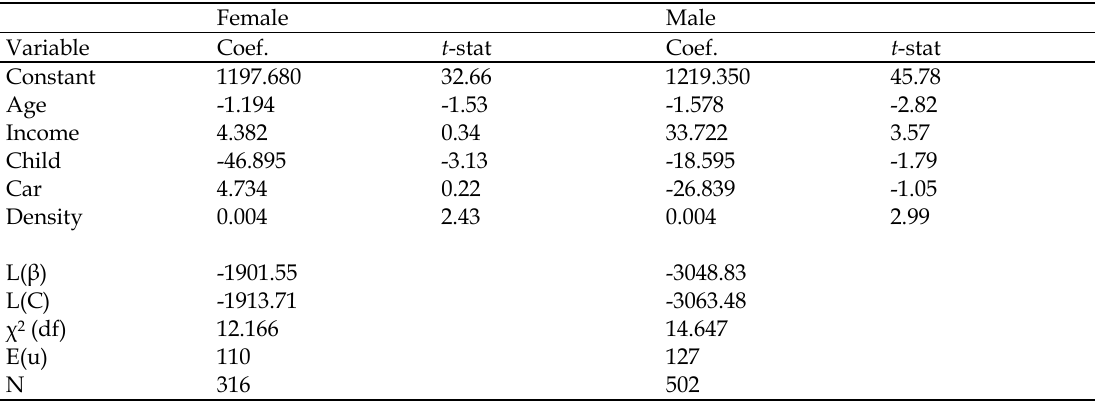
Table 5. Stochastic Frontier Models for the Terminal